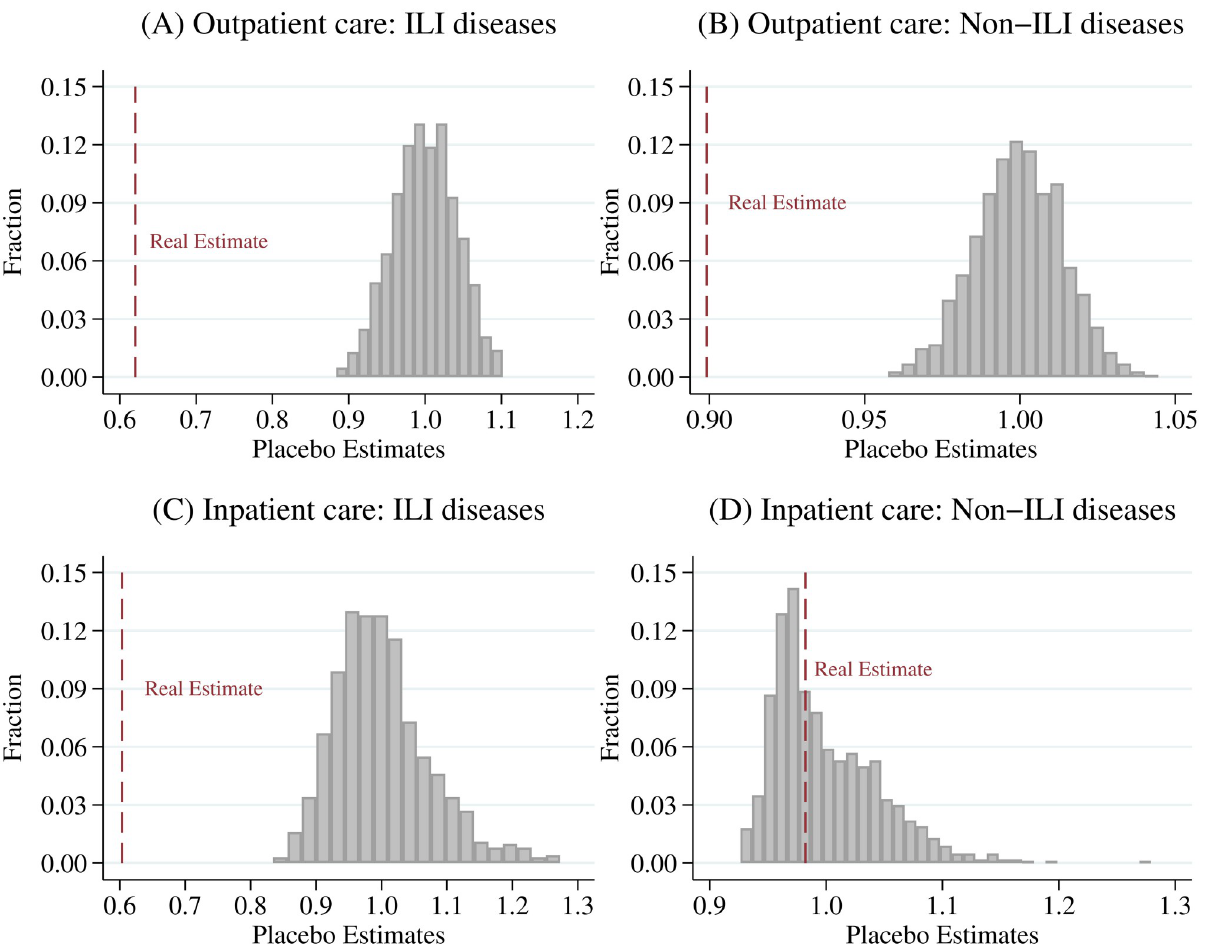
Fig 4. Placebo test: DID design. A: Outpatient care: ILI diseases. B: Outpatient care: Non-ILI diseases. C: Inpatient care: ILI diseases. D: Inpatient care: Non-ILI diseases. We use the 2014–2019 sample and randomly select one year as the pseudo “treated year” in each county and estimate Eq (1). We repeat the above procedures 1,000 times to obtain the distribution of placebo estimates. This figure compares our real estimate with these placebo estimates. The vertical axis displays the relative frequency of the estimates. The gray bars denote the placebo estimates, and the red dashed lines denote the real